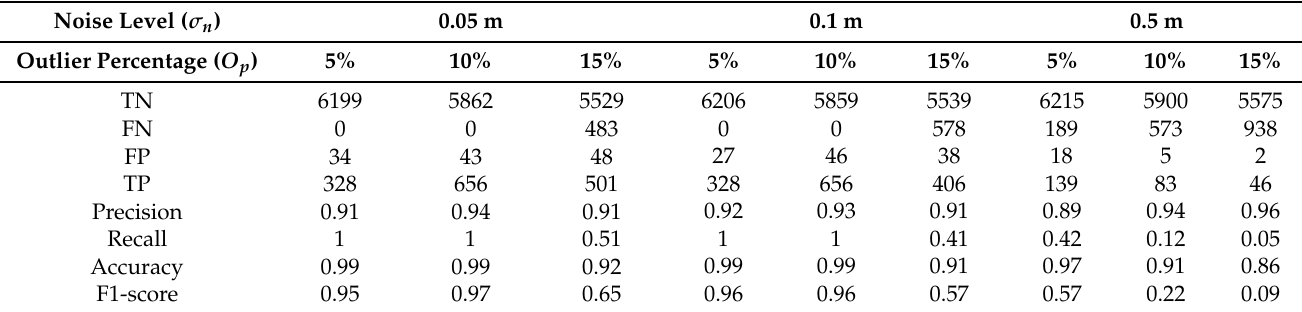
Table 2. Accuracy measures of the classification into outliers and inliers for simulated data for different scenarios (each measure is the median of 1000 MC runs).